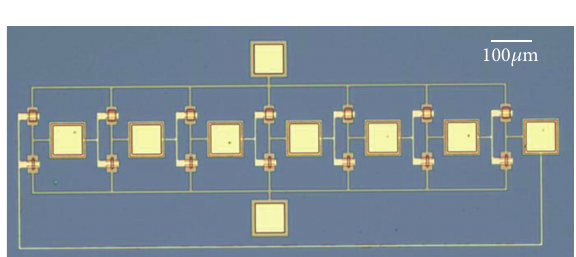
Figure 6: A fabricated seven-stage ring oscillator consisting of ambipolar nc-Si TFTs.